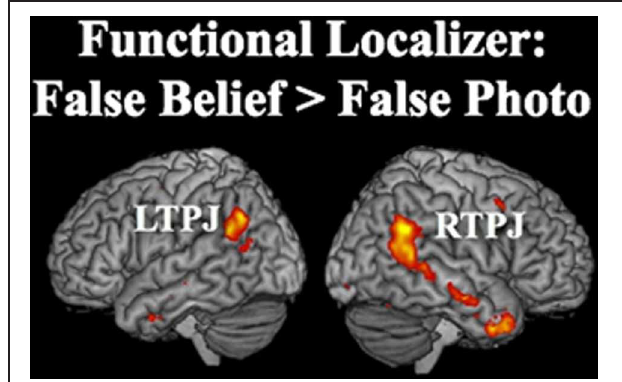
FIGURE 9 | Figure from Young et al. (2010)—Figure 3 from their paper—upper half. Theory of mind activation in the TPJ. TPJ regions where the fMRI activation was higher for stories about mental representations (e.g., false beliefs) than stories about physical representations such as false photographs. Reprinted with permission from Figure 3: Young et al. (2010). Copyright © 2010 Elsevier Ltd. All rights reserved.